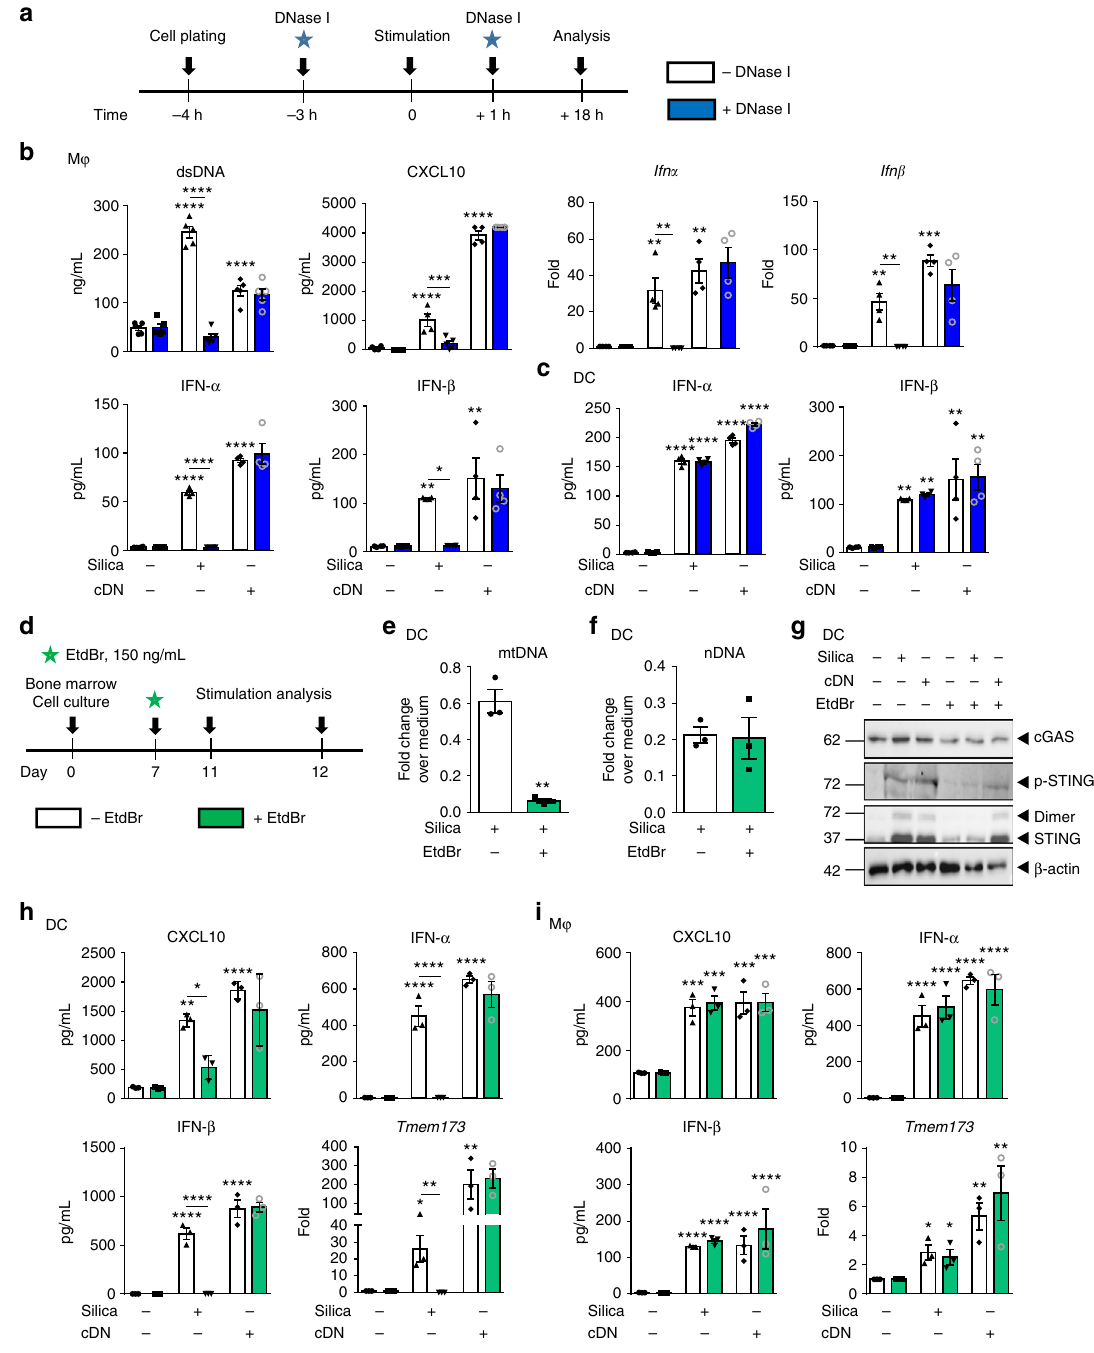
Fig. 7 Extracellular self-dsDNA is key to silica-induced in fl ammatory response in macrophages, not in DCs. a – c Extracellular DNase I treatment (1 µ g/mL) was applied 3 h prior and 1 h after silica exposure (250 µ g/mL) or transfection with c-di-AMP (6 µ g/mL; cDN) for 18 h in bone marrow-derived macrophages ( b ) and dentritic cells ( c ). b Macrophage concentration of extracellular dsDNA and CXCL10 in culture supernatant. Ifn α and Ifn β transcripts measured by real-time PCR on cell fractions and IFN- α and IFN- β protein concentrations determined in culture supernatants by multiplex immunoassay. c Dendritic cell IFN- α and IFN- β protein concentrations determined in culture supernatants by multiplex immunoassay. d – i Mitochondrial DNA replication was inhibited using a low concentration of EtdBr (150 ng/mL) on day 7 of bone marrow cell culture. On day 11, bone marrow-derived DCs ( e – h ) and macrophages ( i ) were unstimulated, stimulated with silica (250 µ g/mL), or transfected with c-di-AMP (6 µ g/mL; cDN) for 18 h. Fold change of ( e ) mitochondrial DNA (mMitoF1 and mMitoR1) and ( f ) nuclear DNA (mB2MF1 and mB2MR1) in untreated versus EtdBr-treated DC exposed to silica, as compared to untreated unstimulated cells. g Immunoblot showing cGAS, phospho-STING, STING protein expression, and dimerization in DCs after EtdBr treatment, with β -actin as a reference. h CXCL10 level in DC supernatant quanti fi ed by ELISA and IFN- α and IFN- β concentrations determined by multiplex immunoassay. Tmem173 transcripts measured by real-time PCR. i CXCL10 level in macrophage supernatant quanti fi ed by ELISA and IFN- α and IFN- β concentrations determined by multiplex immunoassay. Tmem173 transcripts measured by real-time PCR. * p < 0.05, ** p < 0.01, *** p < 0.001, **** p < 0.0001 (Mann – Whitney U analysis). Data are presented as mean ± SEM and are representative of two independent experiments with n = 4 independent cultures. Immunoblots are representative of n = 2 samples per condition ( g ). Source data are provided as a Source Data fi